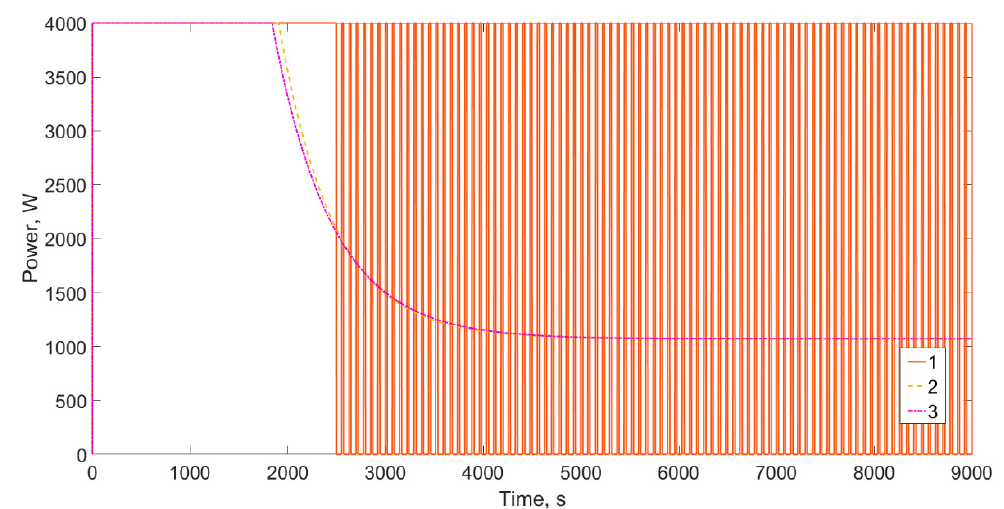
Figure 11. Course of the control signals from the different controllers (no noise): 1—relay, 2—PID and 3—I-PD.